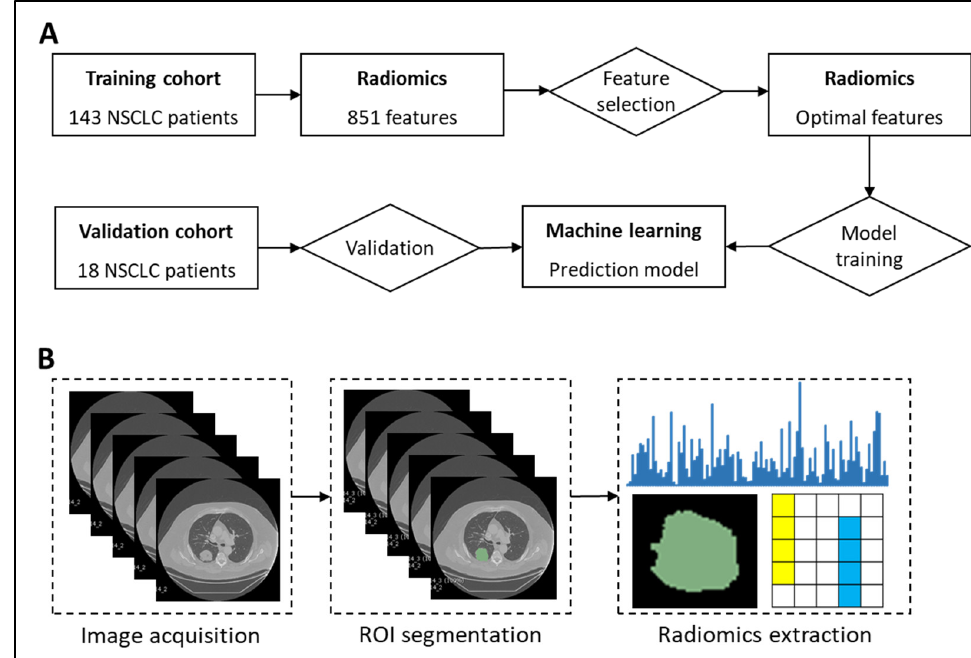
Figure 3. Prediction of EGFR mutation using radiomics, feature selection, and machine learning algorithms. ( A ) Study framework. ( B ) Workflow of radiomics.